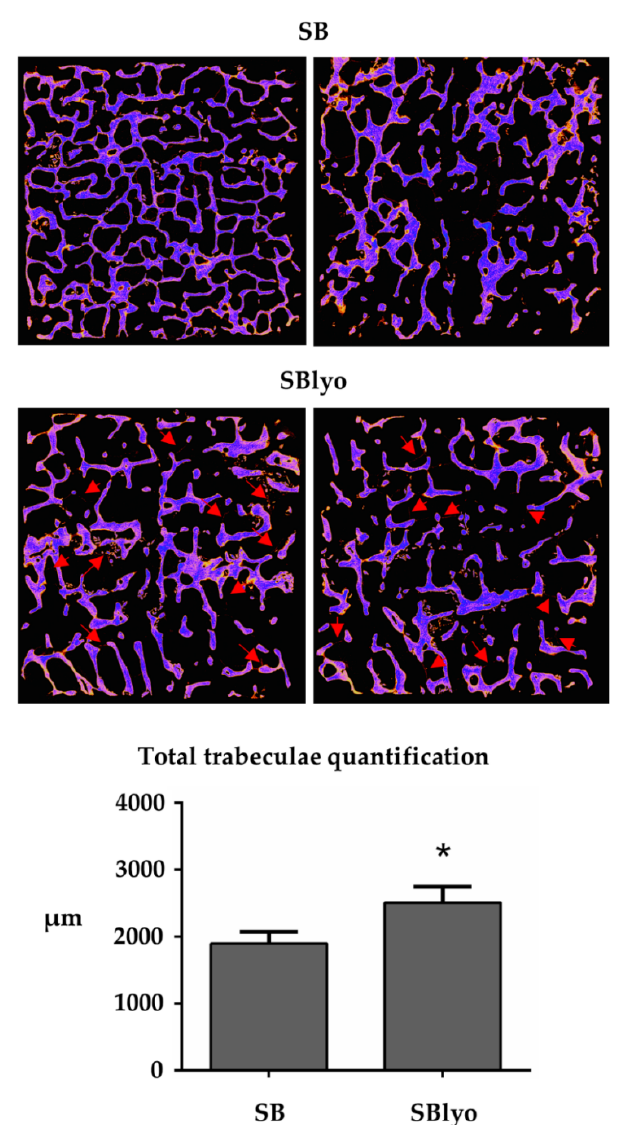
Figure 7. Expression of mature osteoblast markers (ALP, COLL-1, and OCN): marker expression of cells grown on SBlyo (gray) and those grown on untreated SB (black). “*” indicates a significant difference between SB and SBlyo ( p < 0.05).